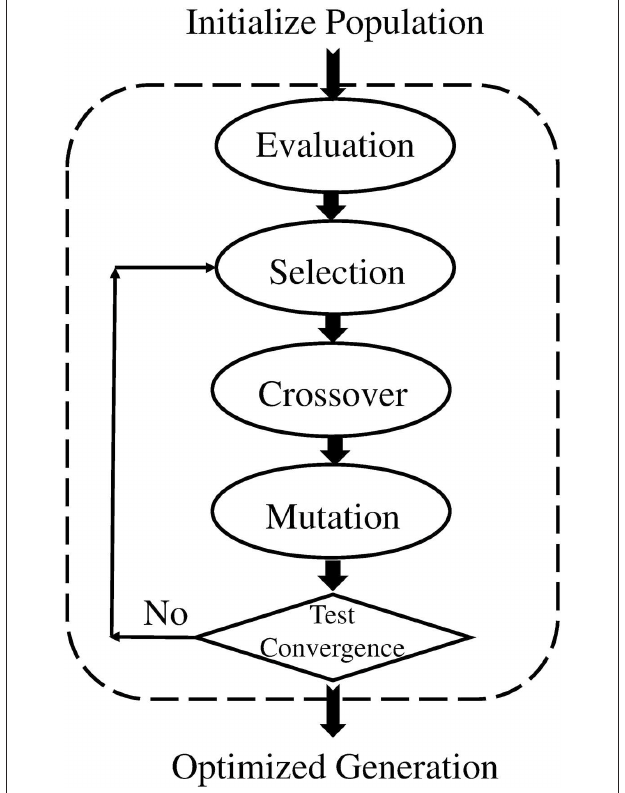
FIGURE 8 | Flow diagram of